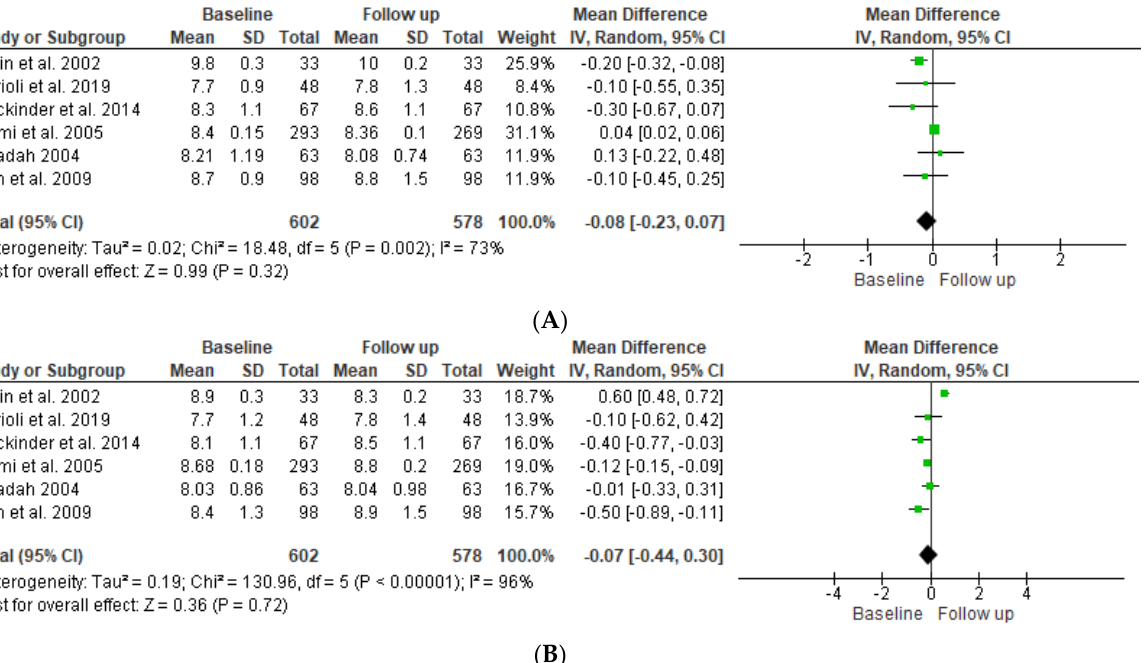
Figure 3. Forest plot showing HbA1c for T1DM patients ( A ) and T1DM and CD patients ( B ) at baseline compared to follow-up.